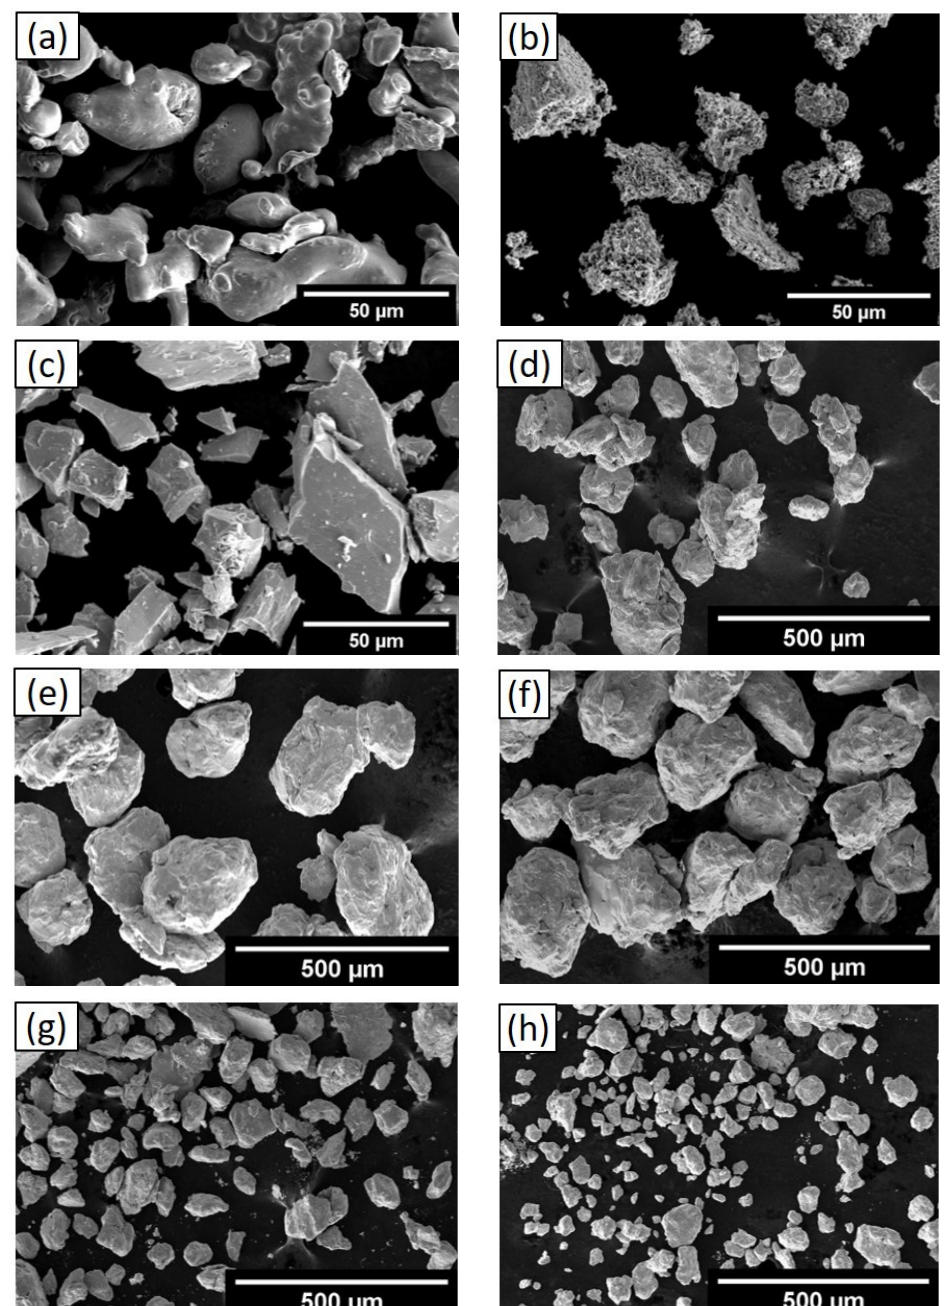
Figure 3. Morphology of the elemental powders: ( a ) Fe, ( b ), Cr and ( c ) Mn, and mechanically alloyed powder at different milling times, after: ( d ) 30 h, ( e ) 60 h, ( f ) 90 h, ( g ) 120 h, ( h ) 150 h. The mechanical alloying process consists of the repetition of cold welding, fracturing, and rewelding of powder particles occurring in the milling jar by collisions of balls against each other and the walls of the jar. The cold welding leads to an increase in particle sizes, while the fracturing leads to the fragmentation of particles [32]. Analyzing changes in the morphology of particles as a function of milling time, it can be concluded that during the first 60 h of MA, cold welding dominates, increasing the average particle size. The subse- quent 30 h of milling does not cause a significant alteration in the particle size. This means that the fracturing process, resulting in the particle size decrease, is in equilibrium with the cold welding process. After 120 h of MA, the fracturing phenomenon causes a contin- uous decrease in the particle size, which emphasizes domination of the fracturing over cold welding. After 150 h of ball milling, the average particle sizes were almost similar to the initial sizes of the particles used at the beginning of the process (but with the bimodal distribution). Similar trends were reported by Haghir et al. [10], whereas Cisneros et al. [33] and Duan et al. [34] observed that the initial sizes of the elemental powders of ~50 μ m after mechanical alloying, up to 170 h in nitrogen, were reduced to 10 μ m. The authors pointed out that first the powder particles flattened and then the prolonging of milling time became equiaxed. Coarser particle sizes observed here, in comparison with the literature data [33,34], are due to the different milling devices and process parameters, including atmospheres. For instance, decreasing the ball to the powder weight ratio from 10:1 to 5:1 can cause a significant increase in the crystallite and particle size of the obtained powder [32]. Cisne- ros et al. [33] used an attritor ball mill with the ball to powder weight ratio of 30:1, the rotation speed of 300 rpm, and nitrogen. Duan et al. [34] used a planetary ball mill, for instance, with a rotation speed of 350 rpm, and with three different types of ball diameters. This explains the differences between the literature data and the results presented here. Moreover, the atmosphere used here differs from the literature cited. The powder ob- tained here is softer in comparison to the hardness measurements presented by the other authors. This suggests that nitrogen content in the bulk powder is lower and, therefore, the number density of hard nitride precipitations can be reduced. This is clearly observed especially when argon atmosphere is used. Figure 4 depicts the microhardness variation of the as-milled powder as a function of the milling time. The average microhardness of the powder increased from 450 ± 35 HV 0.2 (after 0.5 h of powder blending) to 523 ± 45 HV 0.2 after the first 30 h of MA. Note that when the atmosphere changed from argon to nitrogen, the hardness of the powder ab- ruptly increased from 523 ± 45 up to 731 ± 52 HV 0.2 within the same period of time. By further prolonging the milling time, an average hardness almost linearly increased, reach- ing 1068 ± 56 HV 0.2 after 150 h of milling.